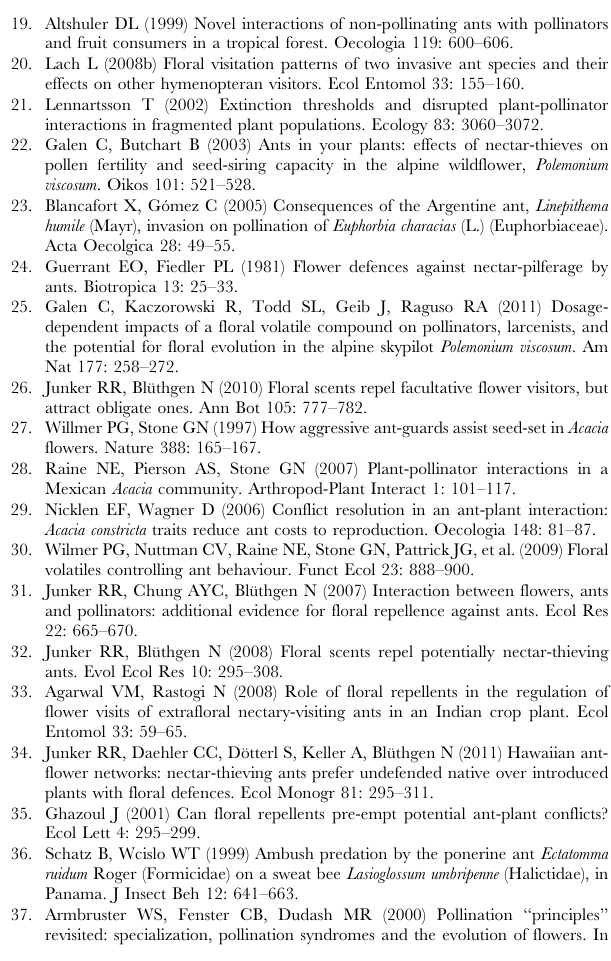
Table S1 Plant species tested against Camponotus novograndensis in tactile trials. K-W tests were for differences between agitated responses in ants from fresh flowers and other floral part used (older, pollen and nectar depleted flowers in most cases) with significant differences shown in bold. Mode of pollinations was determined from visits observed while flowers were selected and peak dehiscence time determined combined with literature searches for each species. N= number of ants used in tactile